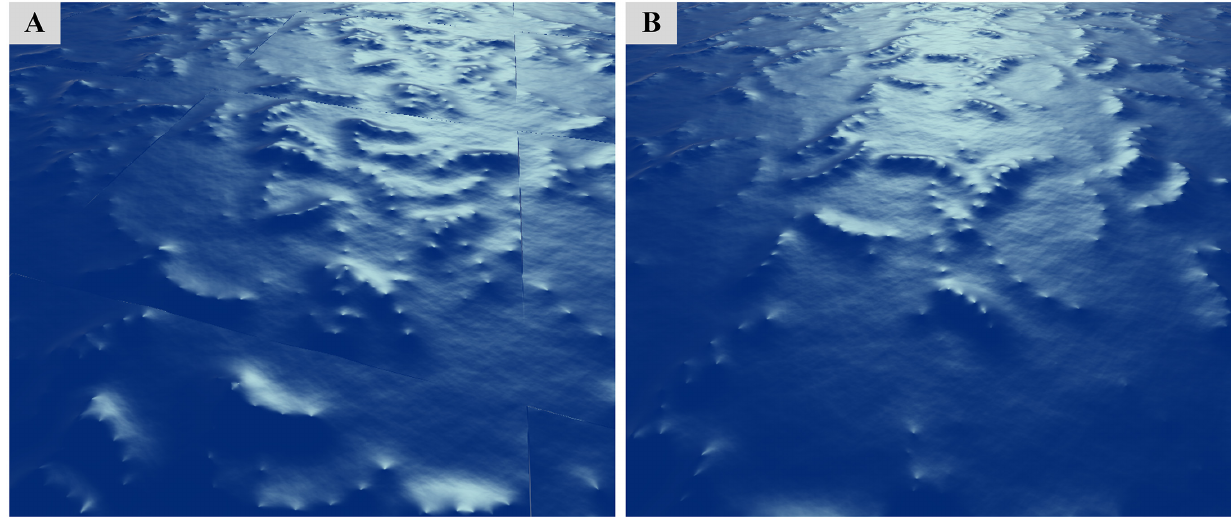
Fig 7. Crack test scenes. (A) Obvious cracks between tiling patches without mirror wave particles. (B) No cracks between tiling patches with mirror wave particles.